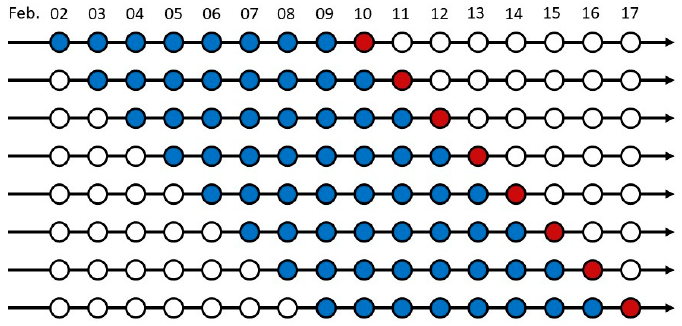
Figure 11. A cross-validation method for time-series data.